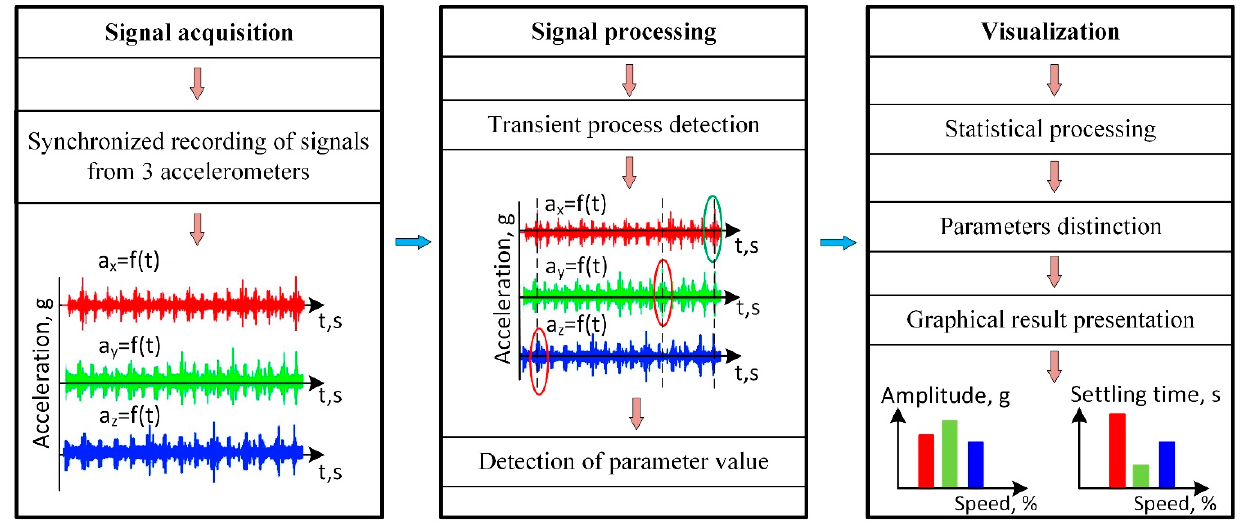
8 of 21 Figure 5. Start positions of the robot used for the measurements of gripper vibrations: ( a ) maximum peri pher al reach on extended position, ( b ) compacted position. In both cases, the reference point was distanced from the z -axis origin by 200 mm.